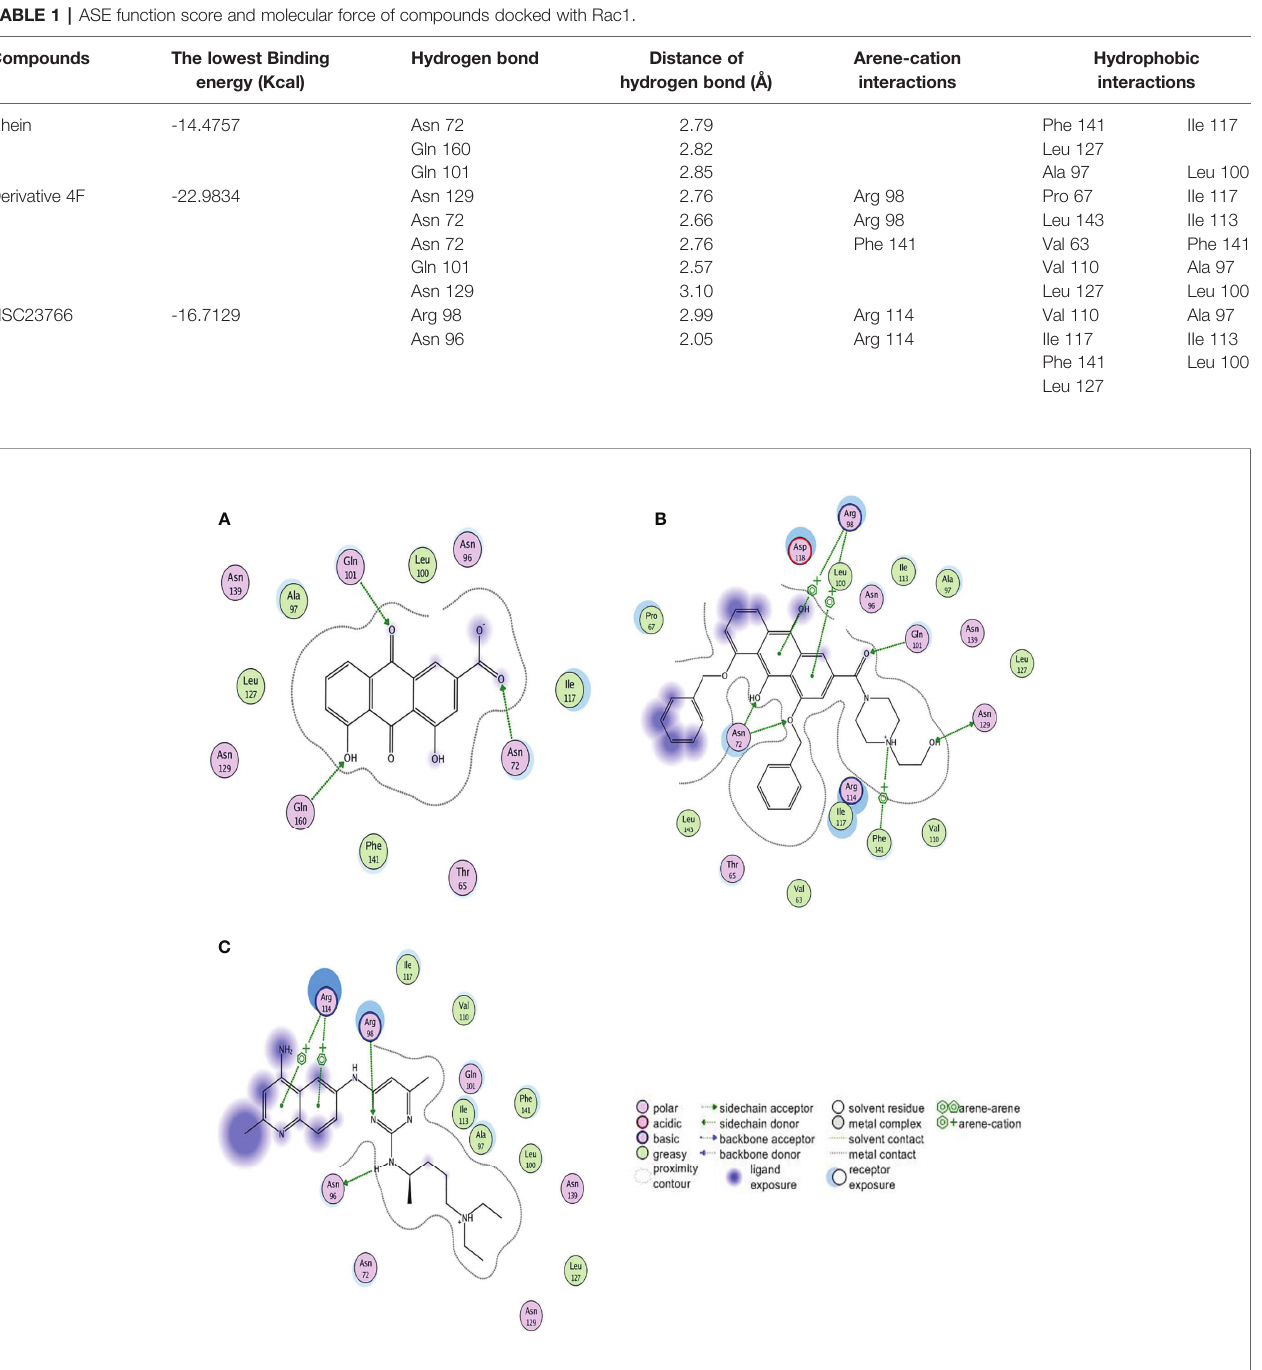
FIGURE 5 | Two-dimensional view of the interaction modes of minimum energy conformations of compounds with Rac1. Hydrogen bonds are shown as dotted arrows, greasy amino acid residues are shown as green circles, and polar amino acid residues are shown as pink circles. (A) Rac1-Rhein complex. (B) Rac1- derivative 4F complex. (C) Rac1-NSC23766